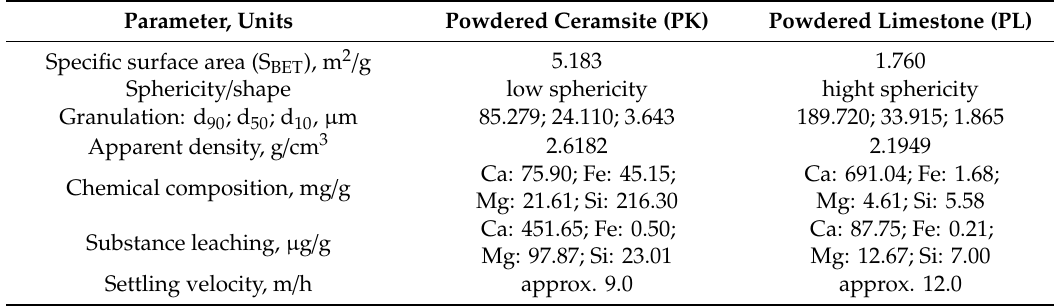
Table 2. Physicochemical properties of the applied powdered materials (adopted according to [33]).